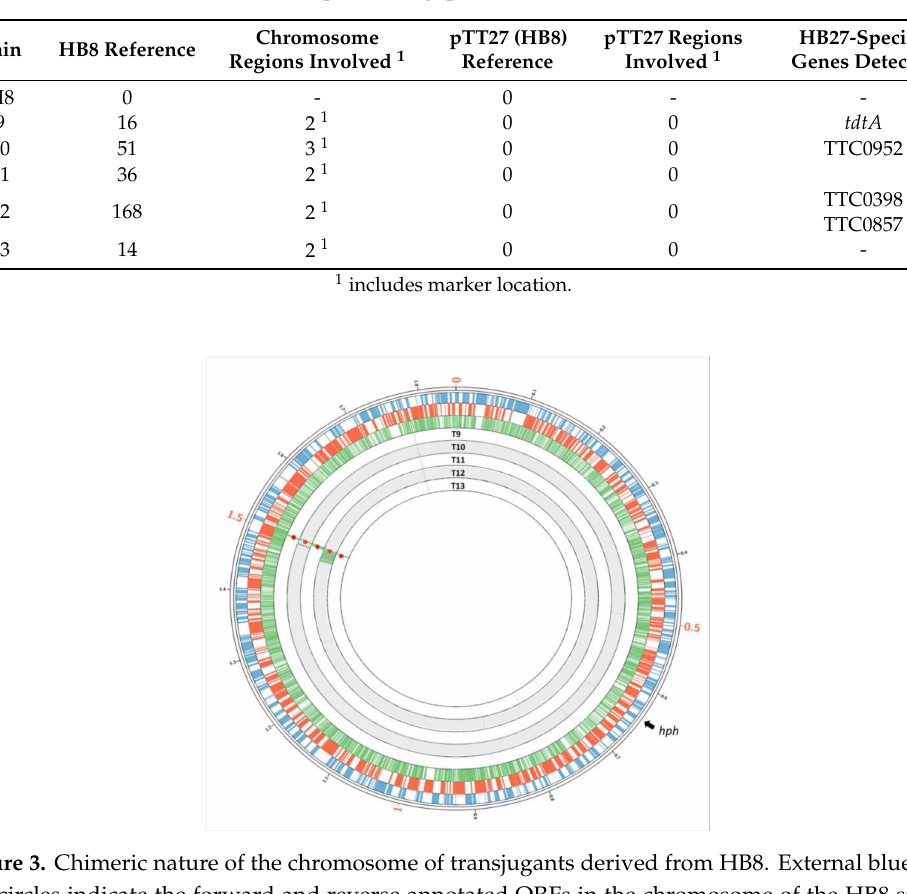
Table 4. Number of specific SNPs found both in parental strain CK1 and in transjugants T9 to T13 respect to the CH8 chromosome and pTT27 megaplasmid.